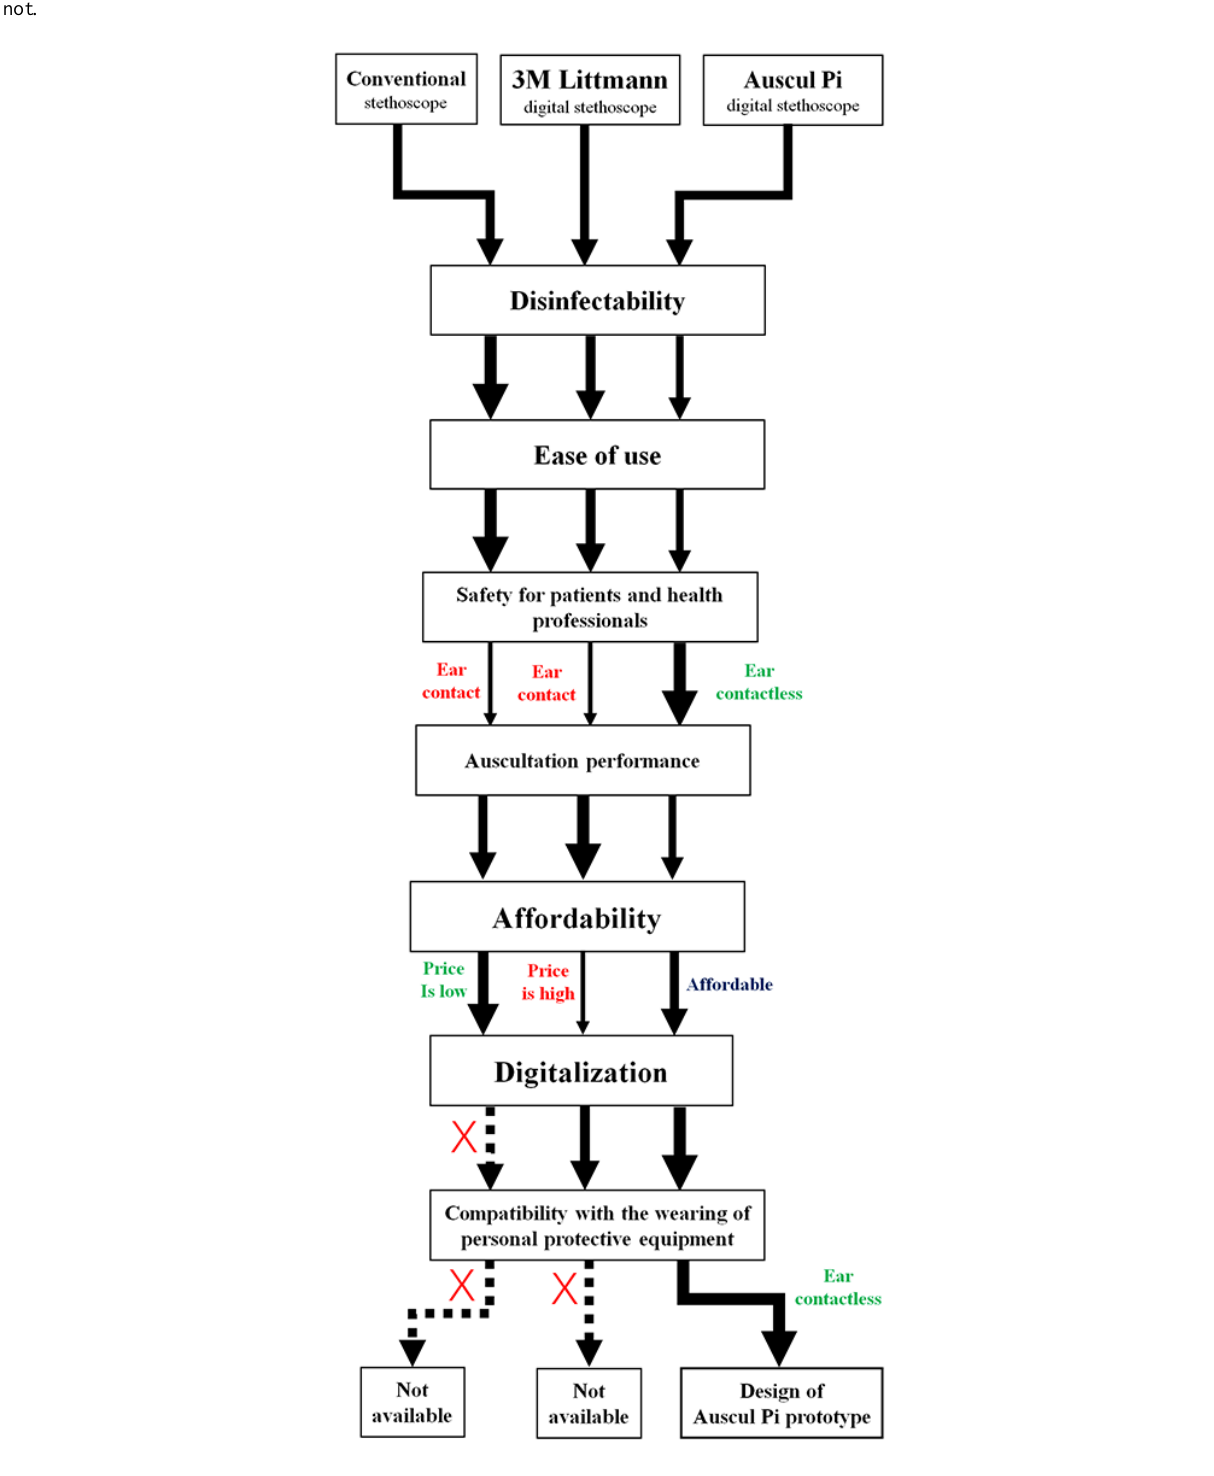
Figure 2. Flowchart of Auscul Pi design based on the evaluation of 7 dimensions in comparison with a conventional stethoscope and 3M Littmann digital stethoscope. Thick solid arrows indicate that the stethoscope performed satisfactorily on the indicated dimension; dashed arrows indicate that it did